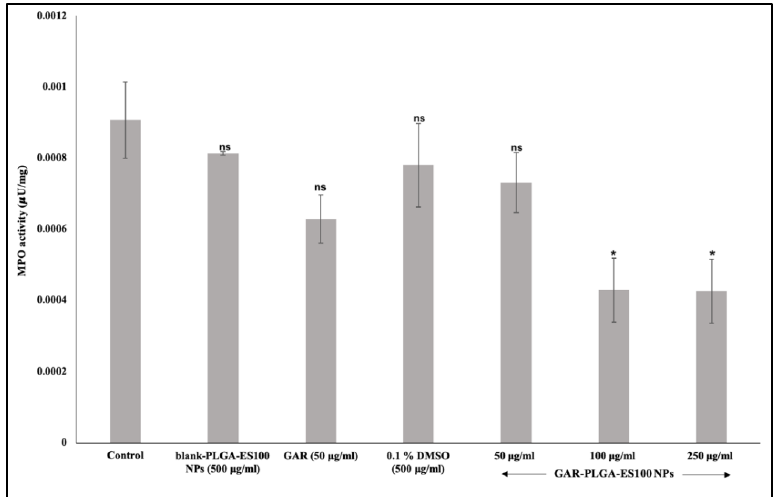
Figure 7. Myeloperoxidase (MPO) assay on CACO-2 cells treated for 24 h with blank-PLGA-ES100 NPs. Concentration was 500 μg/mL, free GAR was 50 μg/mL and GAR-PLGA-ES100 NPs (50, 100, and 250 µ g/mL). Student’s unpaired t-test was carried out to check the statistical significance of the experiment (ns: not significant; * p <